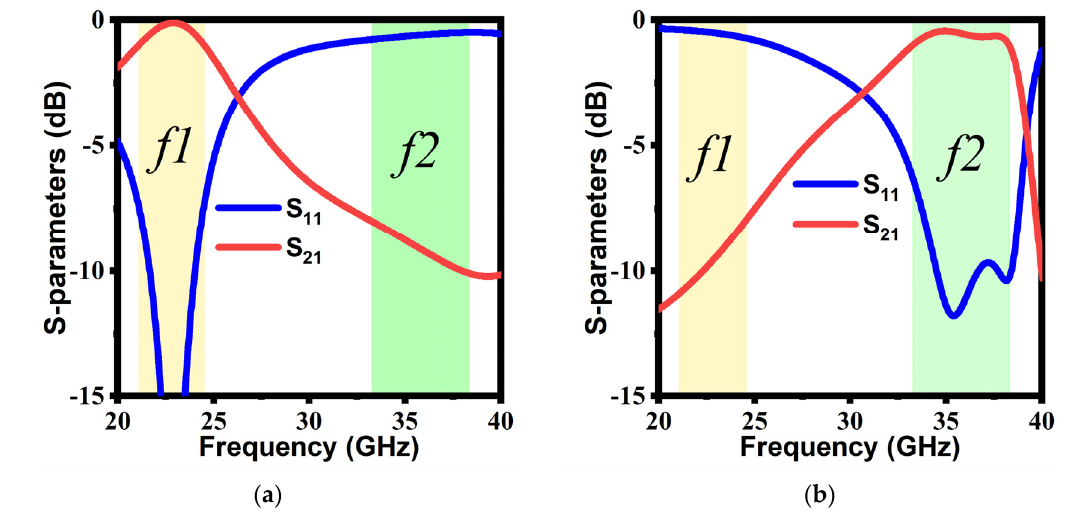
Figure 3. S ‐ parameters: ( a ) TE mode; ( b ) TM mode. Figure 3. S-parameters: ( a ) TE mode; ( b ) TM mode.